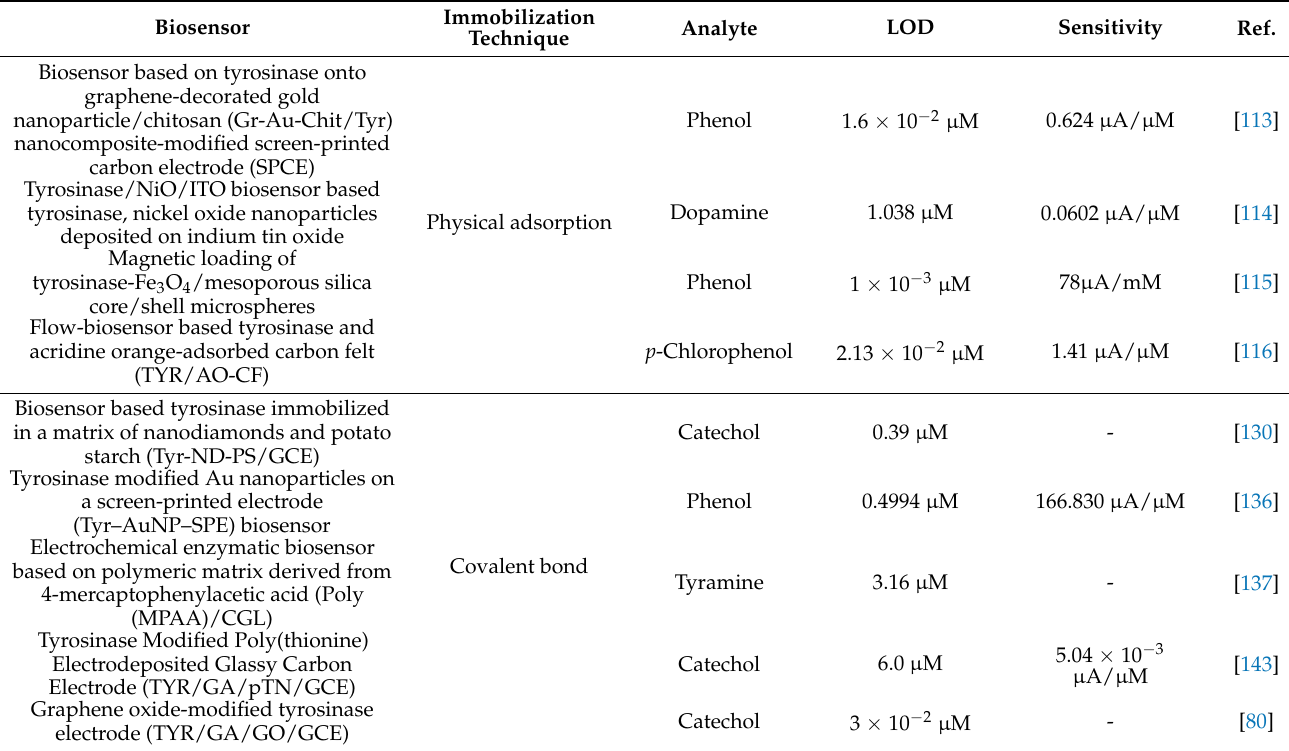
Table 2. Detection limit and sensitivity of biosensors based on tyrosinase, depending on the applied immobilization method and the determined analyte.